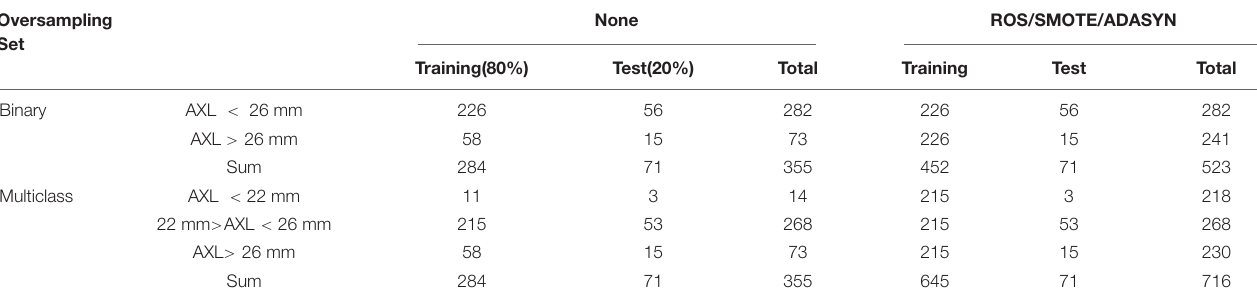
TABLE 2 | Size of original data sets and oversampled data sets. Oversampling Set